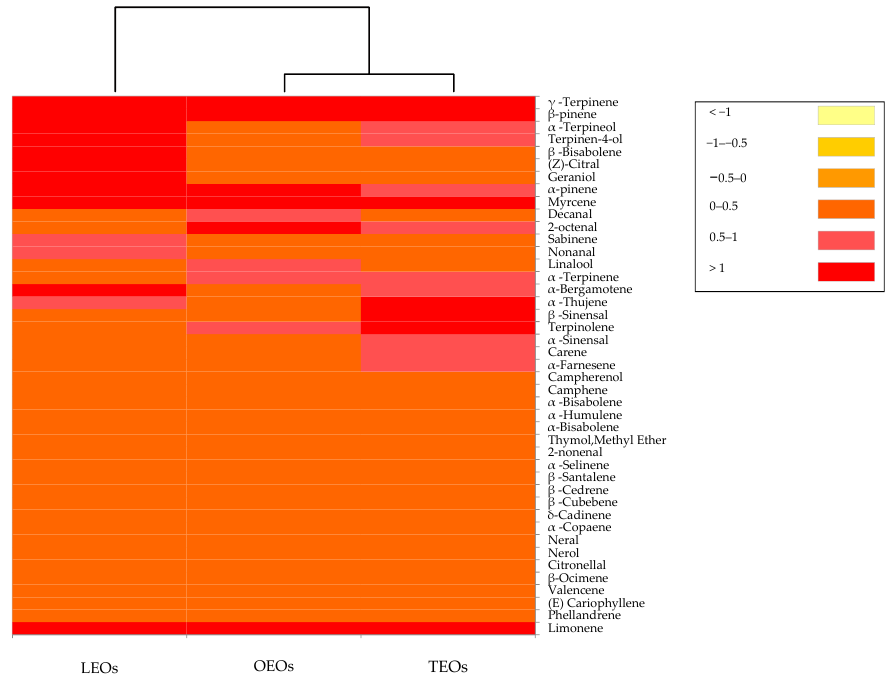
Figure 4. Distribution of the volatile organic compounds among the citrus EOs. The heat map plot depicts the relative concentration of each VOC. Abbreviations: LEOs, lemon essential oils; OEOs, orange essential oils; TEOs, tangerine essential oils.